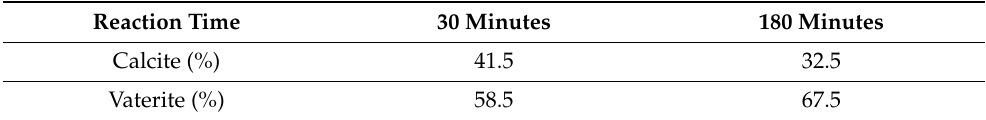
Table 1. Relative phase composition for samples prepared in W:EG 1:5 for different times. All values are expressed in wt% and have an error of about 3%.